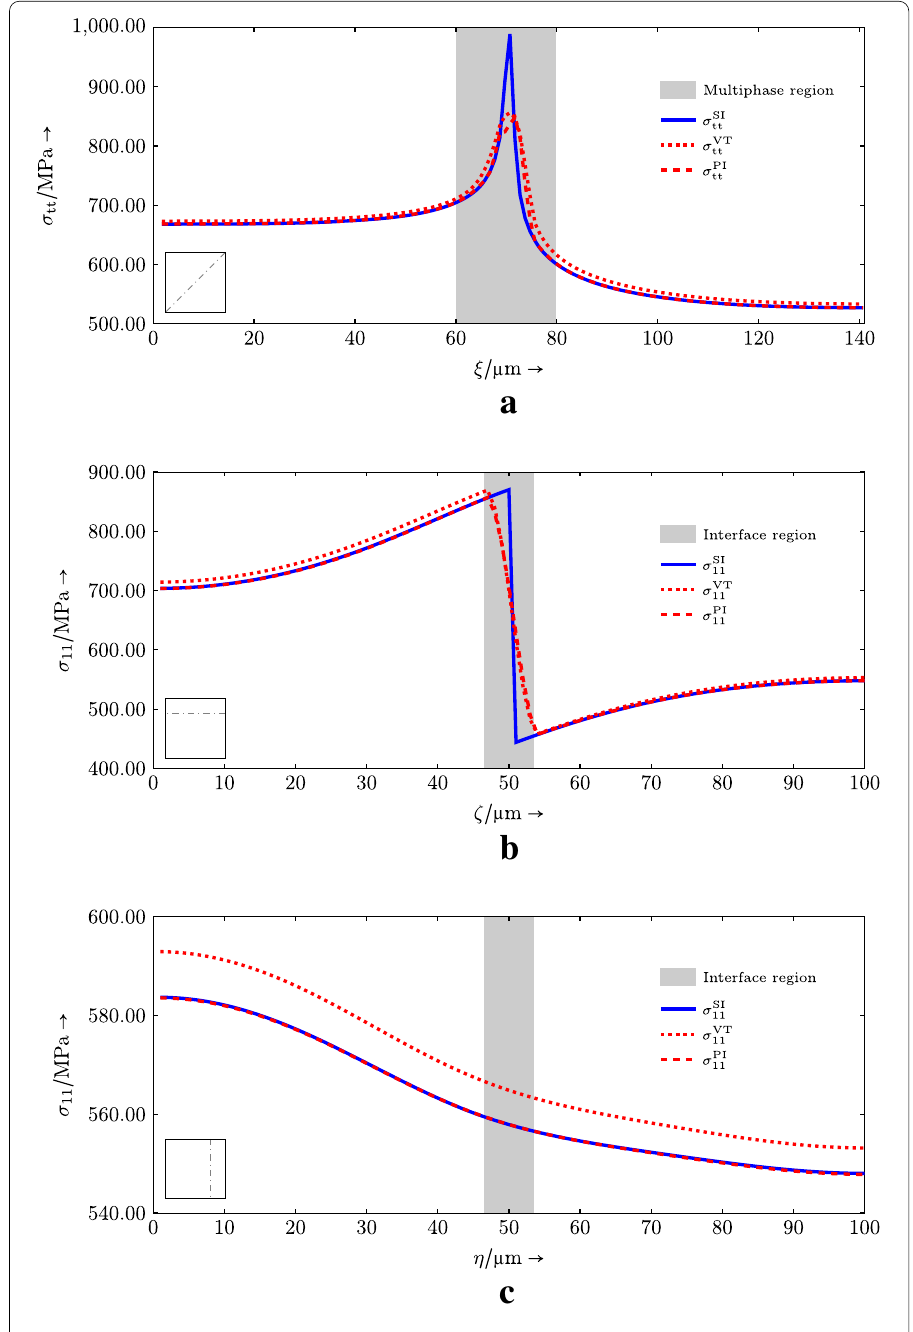
Fig. 18 Results for a σ tt and b, c σ 11 along ξ and ζ , η , respectively: Comparison of the VT and the PI approach to the sharp-interface solution after t = 10 . 0s